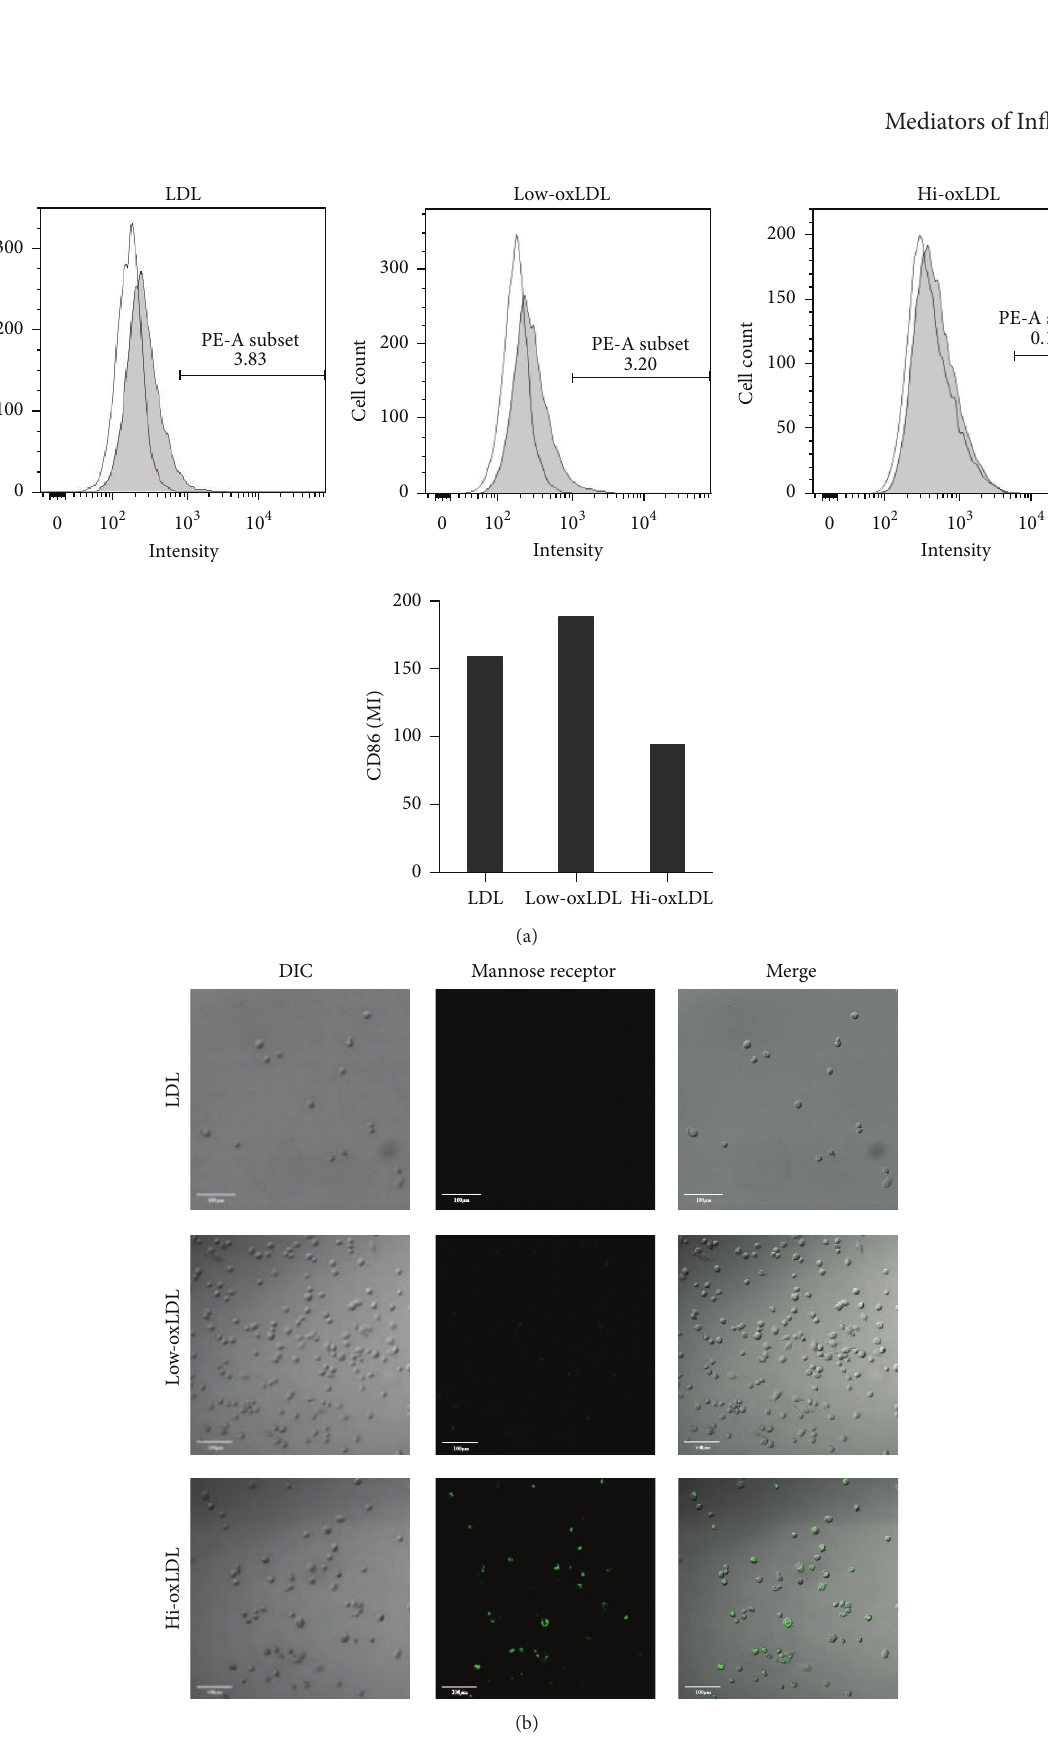
Figure 2: Expression of CD86 and CD206 in response to oxLDL. THP-1 cells were treated with oxLDL (50 𝜇 g/mL) for 96 h. (a) THP-1 cells were stained with anti-CD86-PE antibodies and analyzed by flow cytometry. (b) THP-1 cells were stained with anti-CD206-FITC antibodies and observed by confocal microscope ( ×